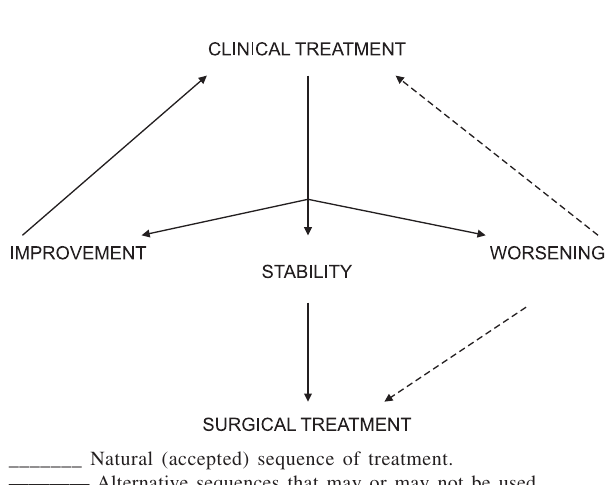
Figure 1 - Treatment scheme for Intermittent